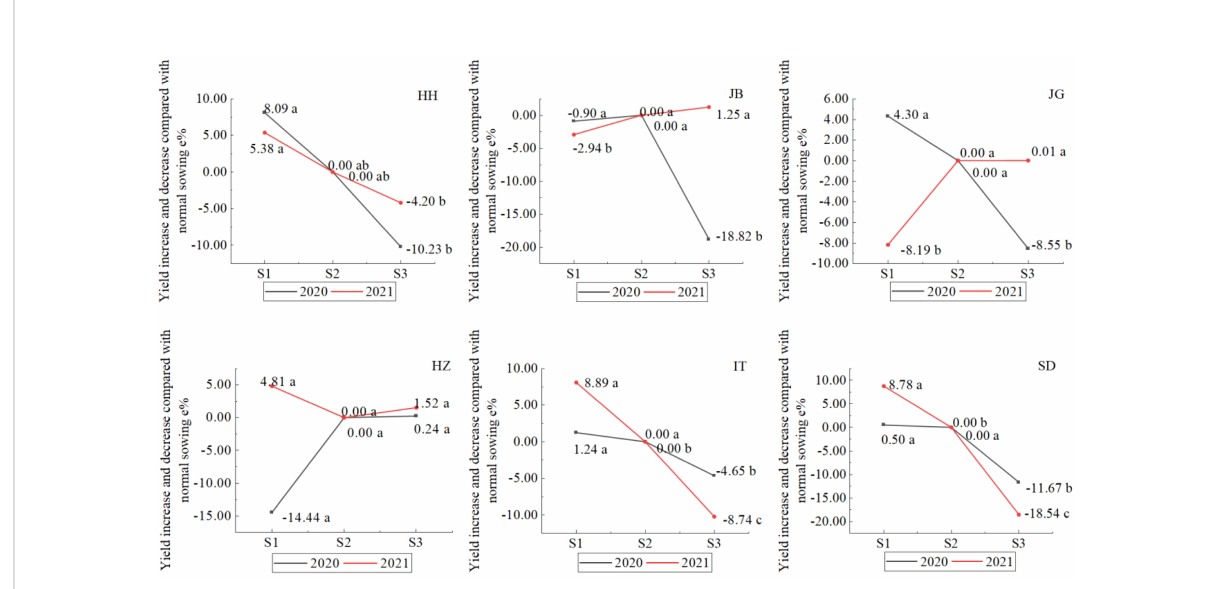
FIGURE 9 Effect of sowing date on sorghum grain yield in different locations (Letters a – c), after data means difference signi fi cance at 0.05, the same letters mean not signi fi cant).